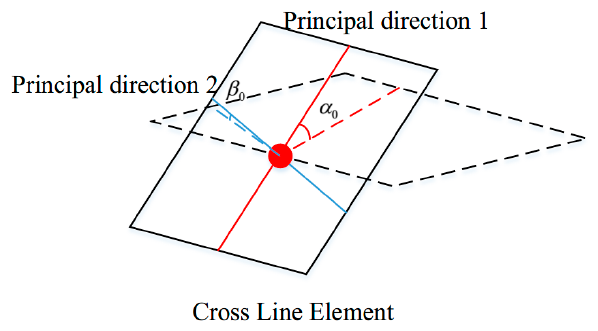
Figure 6. Cross-point of CLE.